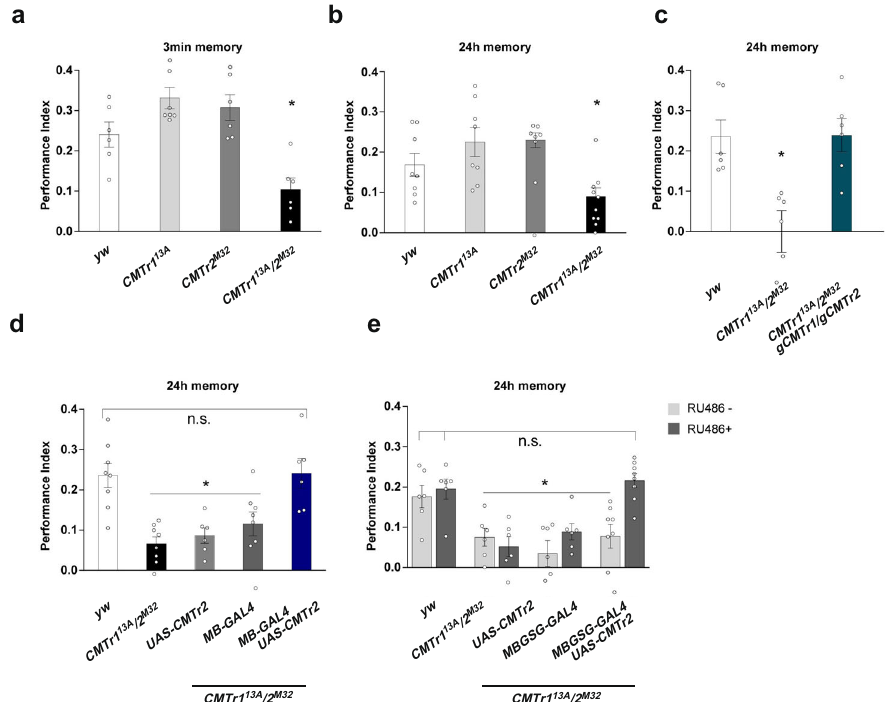
Fig. 2 mRNA cap 2 ′ - O -ribose methylation is required for reward learning in Drosophila . a , b Appetitive memory immediately ( a ) and 24 h ( b ) after training of control (white) and CMTr1 13A (light gray) and CMTr M32 (dark gray) single and double mutant (black) fl ies shown as mean ± SE. n = 8 for A and n = 6 for B, except CMTr1 13A / 2 M32 n = 10, p ≤ 0.006. c Rescue of the learning defect in CMTr1 13A ; CMTr2 M32 double mutant fl ies by genomic fragments (blue) shown as mean ± SE. n = 6, p = 0.002. d , e Rescue of the learning defect in CMTr1 13A ; CMTr2 M32 double mutant (black) fl ies by constitutive ( d , n = 8, except UAS-CMTr2 in light gray and MB-GAL4 UASCMTr2 in blue in CMTr1 13A / 2 M32 n = 6, dark gray: MB-GAL4 ) or conditional ( e , n = 6, except MBGSG-GAL4 UASCMTr2 in CMTr1 13A / 2 M32 n = 8) expression of CMTr2 in mushroom bodies from UAS in the absence (light gray) or presence (dark gray) of RU486 shown as mean ± SE, p ≤ 0.0001. Statistical analysis was done by one-way ANOVA followed by Dunnett ’ s multiple comparison test. Source data for learning and memory experiments are provided as a Source Data fi